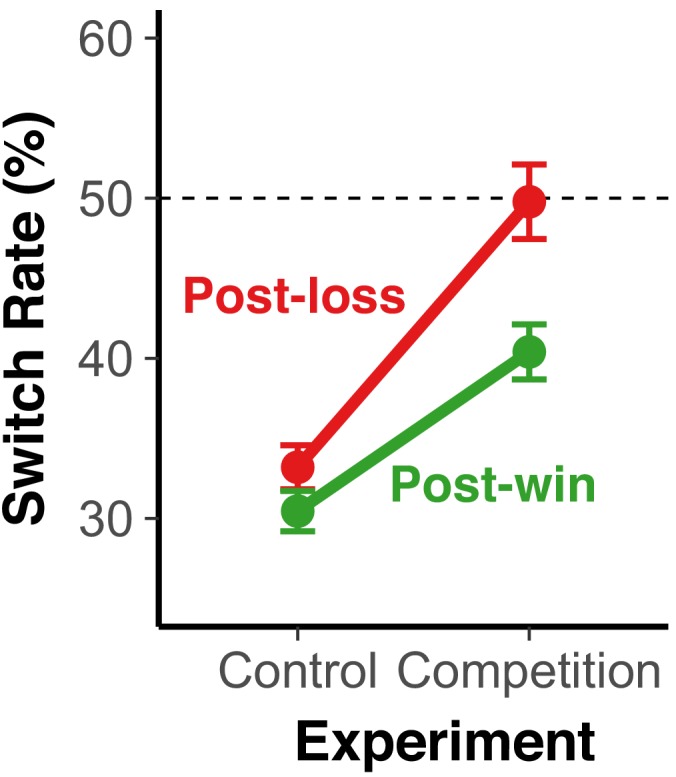
Switch rates when competing versus not competing.The fox-rabbit task is a variant of the voluntary task-switching task, which is a standard paradigm for studying the ability to control selection of action rules in the absence of external prompts (Arrington and Logan, 2004). The most important result in this paradigm is a strong tendency to perseverate the last task/rule (i.e., a switch rate around 30%). In the standard paradigm, subjects are instructed to select tasks as randomly as possible. In contrast, in the fox-rabbit task, the competitive situation in combination with the informative, trial-by-trial feedback should provide an actual incentive to behave unpredictably. Therefore, it is useful to compare performance in the fox-rabbit task to the standard results from the voluntary switching paradigm. The contrast between the competitive situation in Experiment 4a and the non-competitive, but otherwise identical situation in Experiment 4b, allows such a comparison. As apparent, in the control experiment, switch rates were similar to results from the standard voluntary-switching situation and showed no robust feedback effect. In contrast, the competitive situation showed both larger switch rates and a strong win-stay/lose-shift bias (see also Figure 2). The fact that different processes occur in the competitive compared to the non-competitive situation is also apparent form the fact that average RTs in the first are much larger than in the latter (competitive: mean RT = 892 ms, SD = 118; non-competitive: mean RT = 577 ms, SD = 133) at comparable error rates (competitive: mean errors = 5.52%, SD = 1.40; non-competitive: mean errors = 6.80%, SD = 2.21). These results indicate that the competitive situation prompts participants to counter the perseveration bias, albeit at the cost of much longer RTs. This time cost probably reflects the use of the model of the opponent and active processing of the informative feedback--which in turn is likely to introduce the win-stay/lose-shift bias.